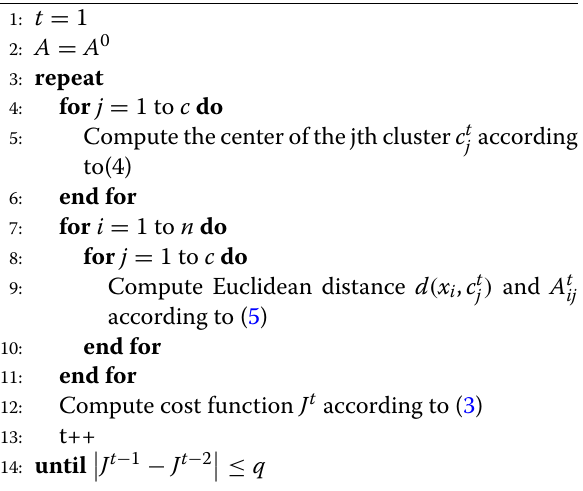
Algorithm 1 Fuzzy-C-Means ( T , q , c , A